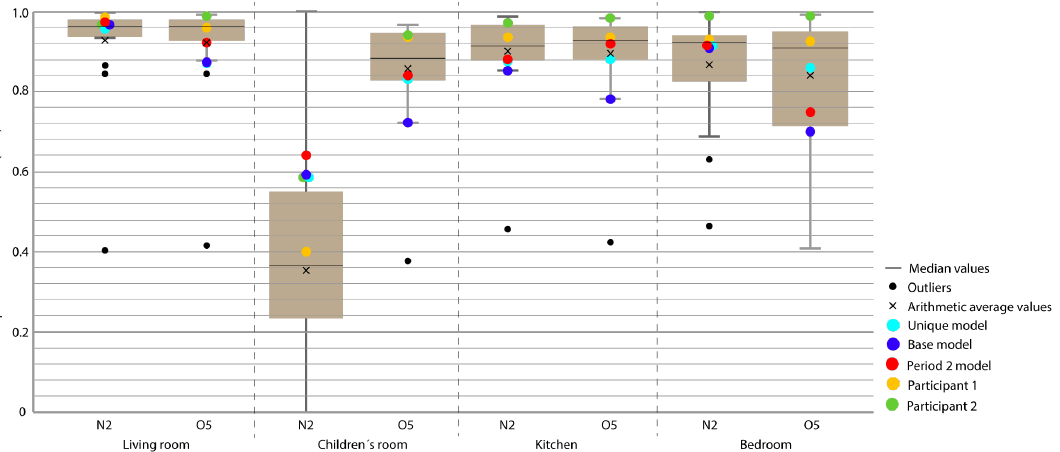
Figure 5. Energy Spearman’s rank correlation coefficient ( ρ ) for Period 2 (fixed set point at 30 ◦